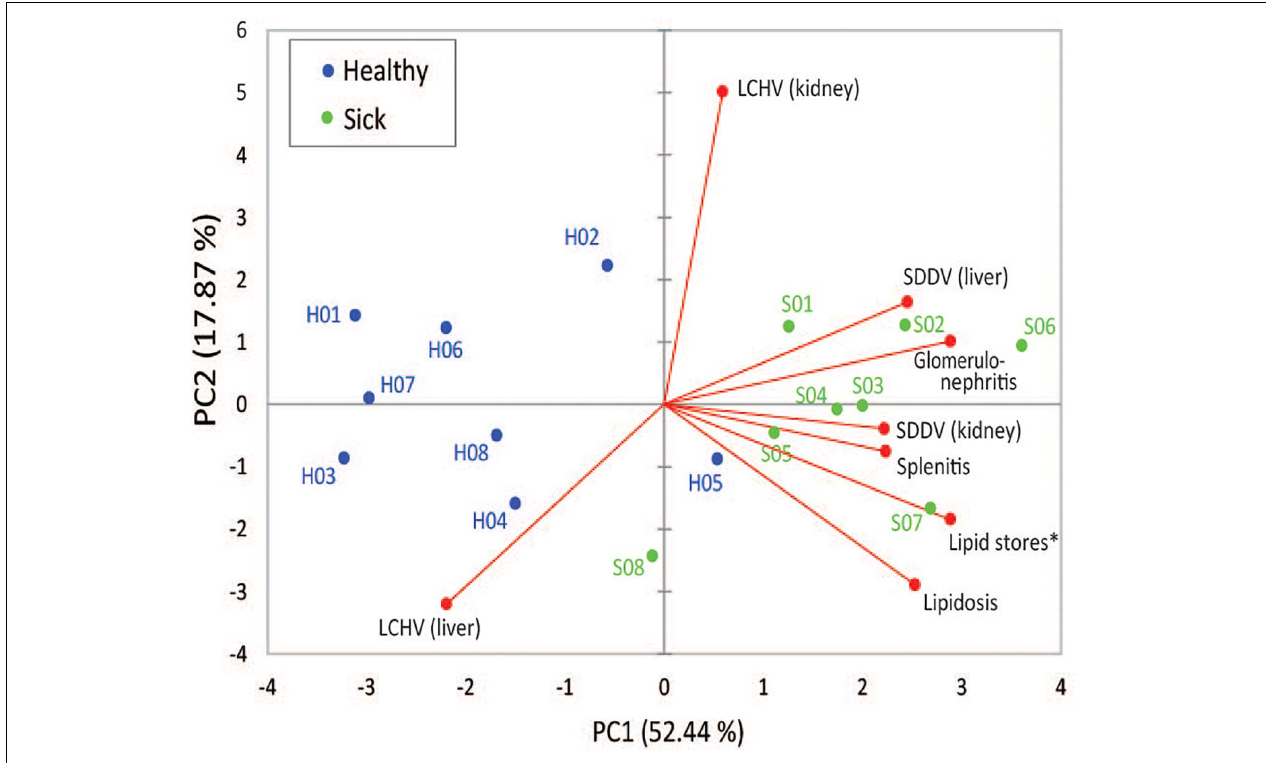
FIGURE 3 | First and second components of principal component analysis (PCA), showing the relationship among SDDV and LCHV loads and histopathology features (red dots) and the overlay distribution of the individual sample of healthy (H01–H08, blue dots) and sick (S01–S08, green dots) barramundi juveniles in this study. Asterisk, for graphical purposes, lipid store values were multiplied by